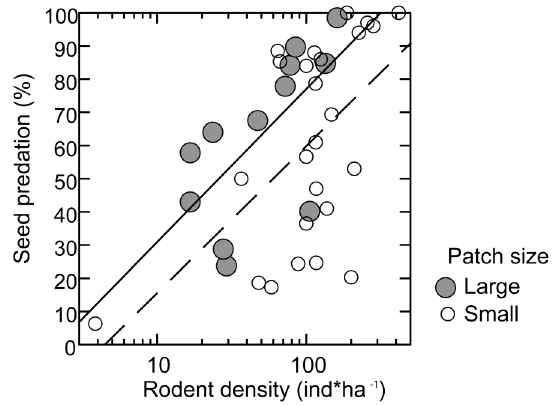
Fig 3. Seed predation in relation to rodent